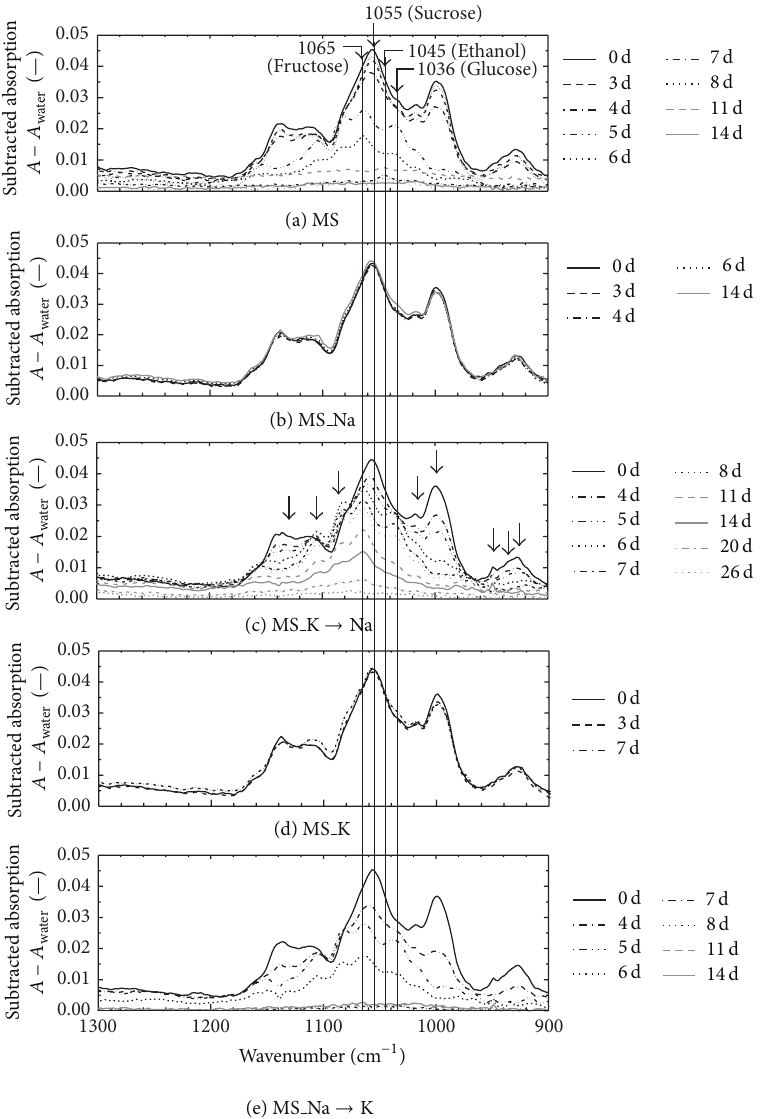
Figure 1: Time behavior of the FT-IR/ATR spectra of the basal MS medium (a) and of the modified MS salt media represented by MS Na (b), MS K → Na (c), MS K (d), and MS Na → K (e) during